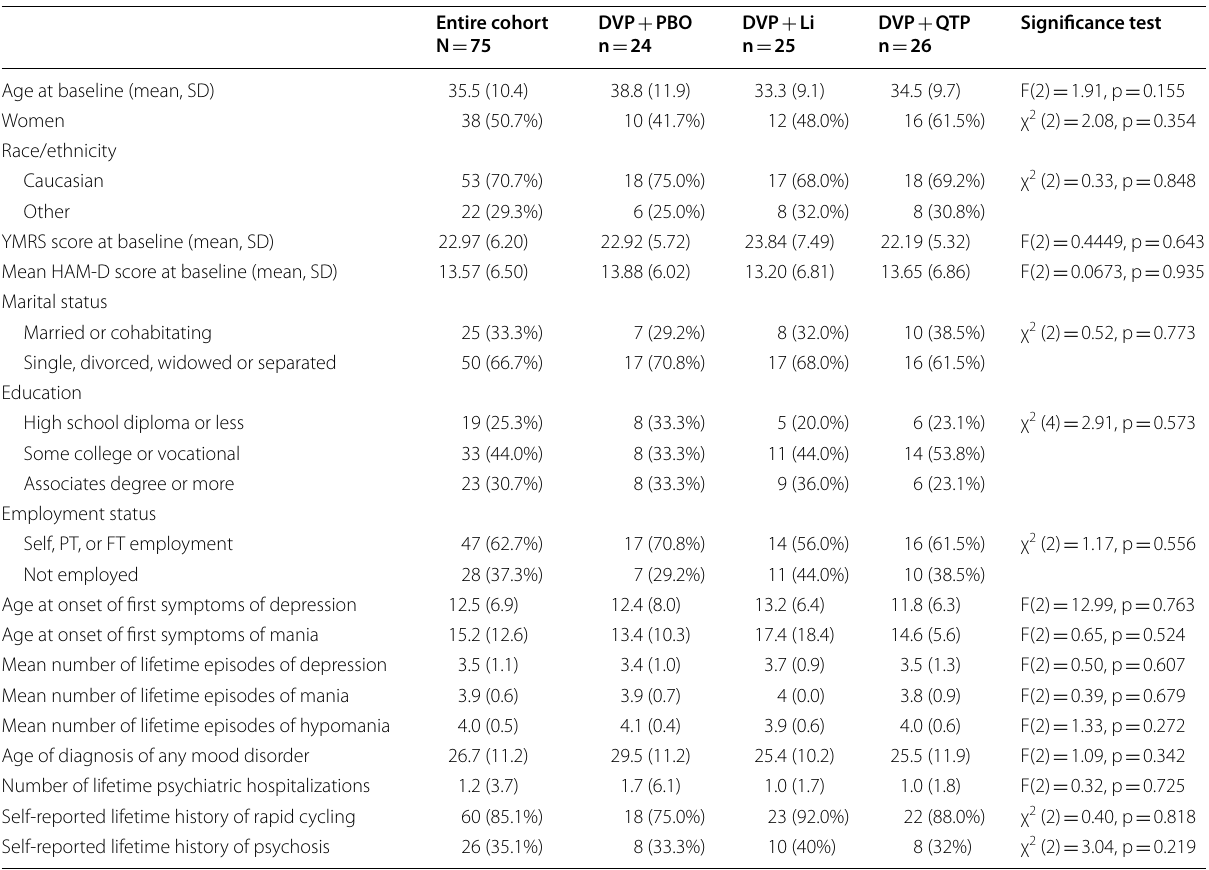
Table 2 Baseline characteristics of